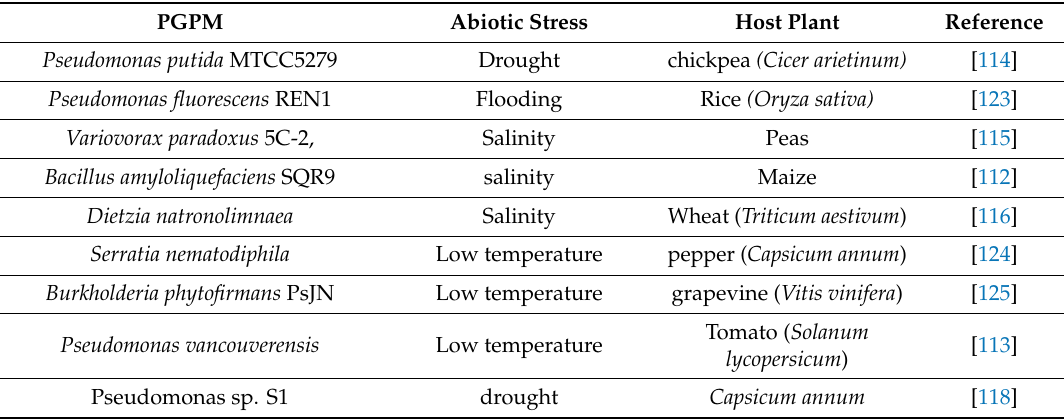
Table 2. Examples of PGPM that enable plants to withstand abiotic